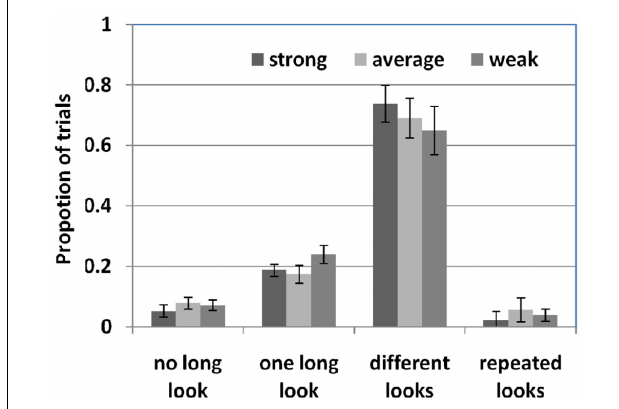
FIGURE 5 |The proportion of trials with long looks across multiple word segments within a trial. There are four trial categories: (1) no long look in a trial; (2) only one long look in one of the four word segments; (3) more than one long look on different objects when hearing different words; and (4) long looks on the same object across different word